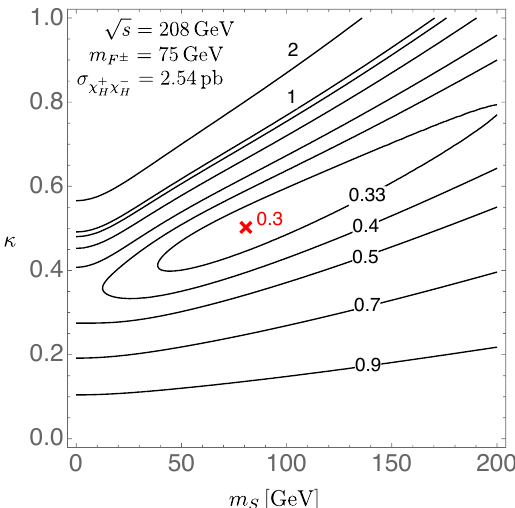
Figure 6 . Chargino pair production cross section, (cid:27) normalized to the charged higgsino pair production cross section (cid:27) as a function of the coupling (cid:20) and singlet mass m S , for m the point of maximal s and t -channel interference, at which the cross section is minimal. Cross sections are obtained from